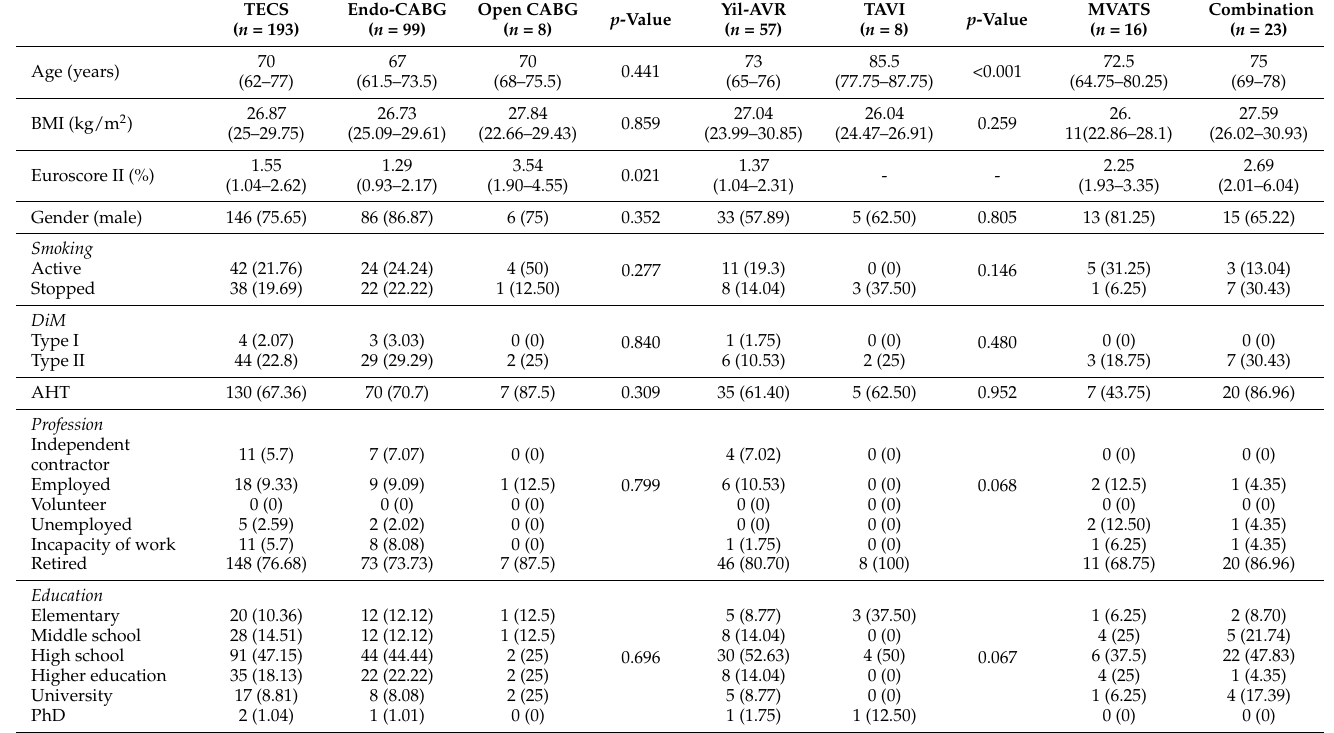
Table 1. Demographics and medical history. Data is represented as n (%) and median (IQR).